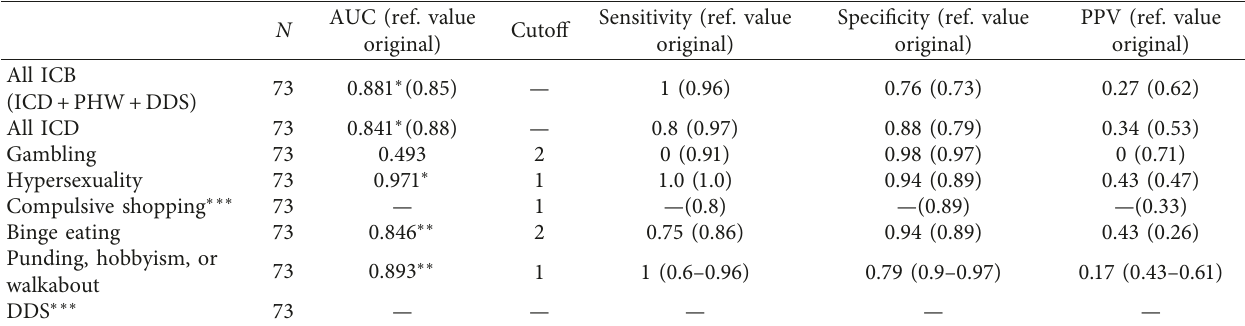
Table 2: Calculation of PPV and speculative calculation of AUC, sensitivities, and specificities of the Flemish translation of QUIP in comparison to the original version validated by Weintraub and coworkers